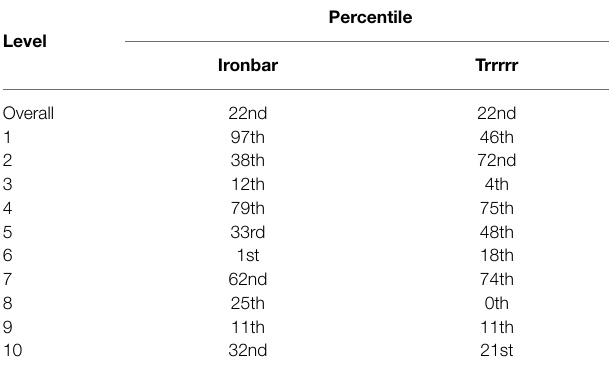
TABLE 7 | Percentile for “ironbar” and “Trrrrr” with respect to children’s